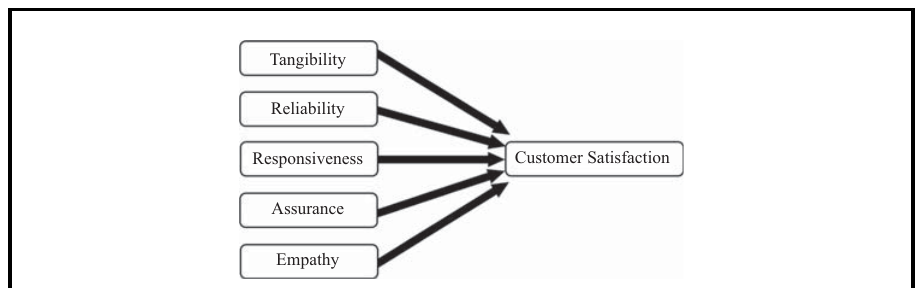
Figure 1 Relationship between SERVQUAL dimensions and customer